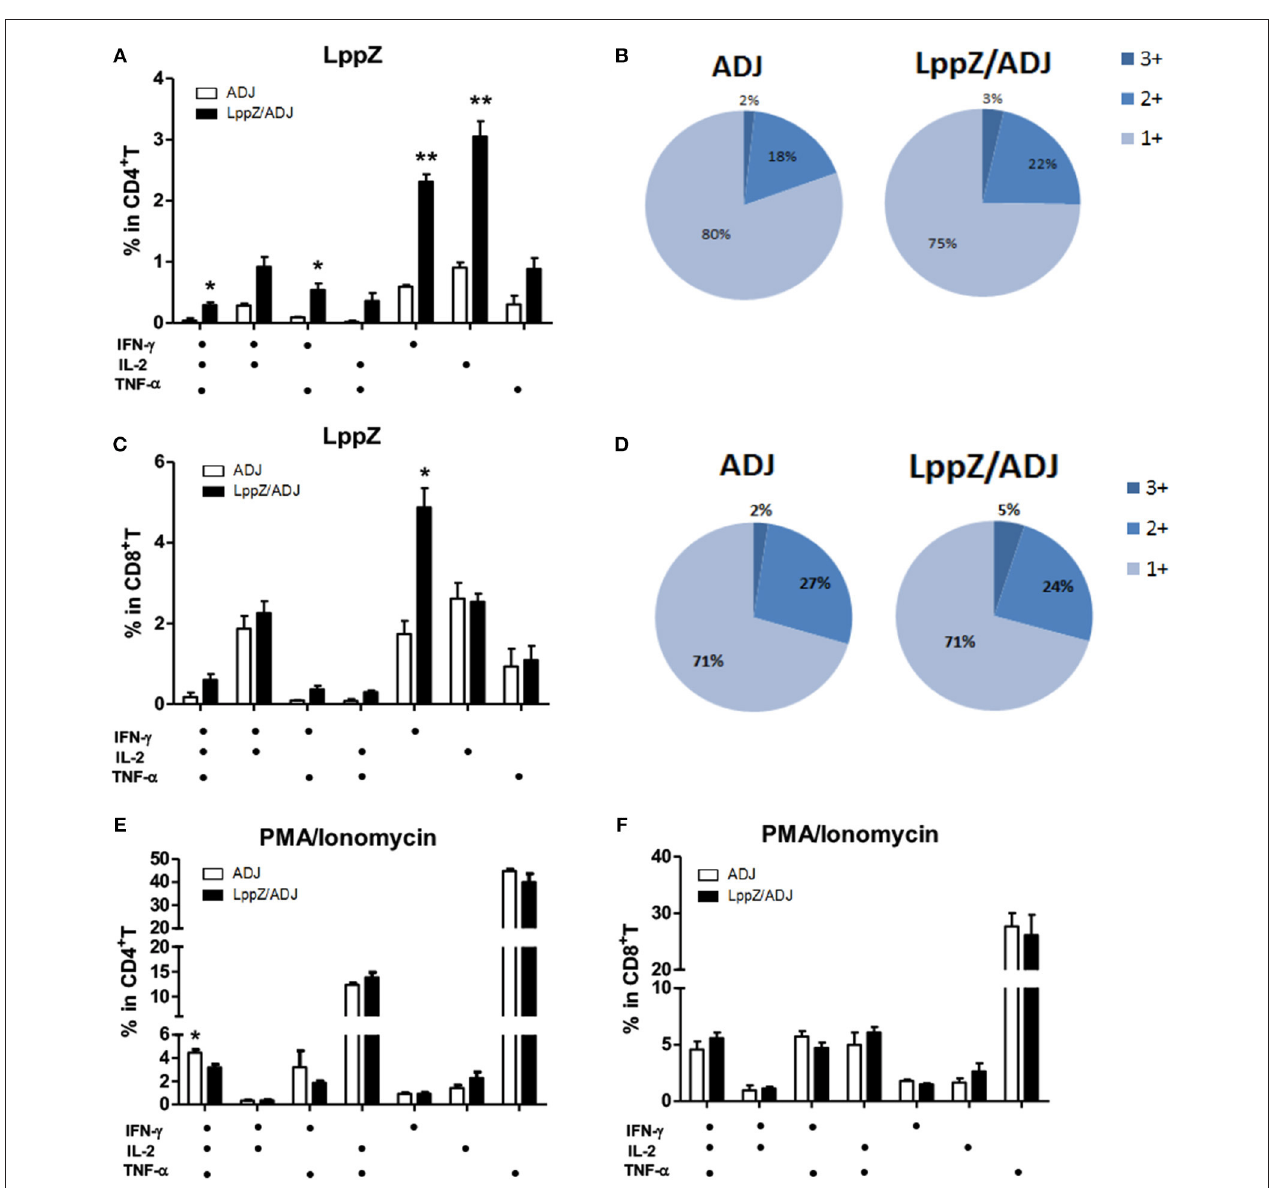
FIGURE 4 | Polyfunctionality of CD4 + or CD8 + T cells responding to LppZ in immunized mice. Splenocytes from each mouse were collected and stimulated ex vivo with LppZ or PMA/Ionomycin. Frequencies of antigen-specific CD4 + (A) or CD8 + (C) T cells expressing single and multiple cytokines were analyzed by flow cytometry. Single or multiple cytokine production is shown on the x-axis of the bar chart ( n = 3–6 mice per group). The percentages of CD4 + (B) and CD8 + (D) T cell expressing single (1 + ), double (2 + ) or triple (3 + ) cytokines are represented as pie charts. (E,F) : frequencies of cytokine-producing CD4 + (E) or CD8 + (F) T cells upon PMA/Ionomycin stimulation * p < 0.05, ** p <